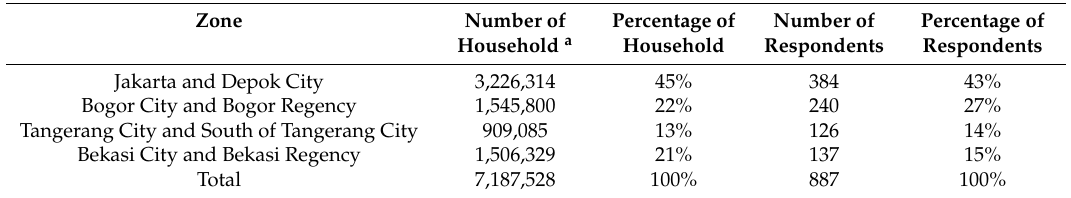
Percentage of Number of Percentage of Household a Household Respondents Respondents